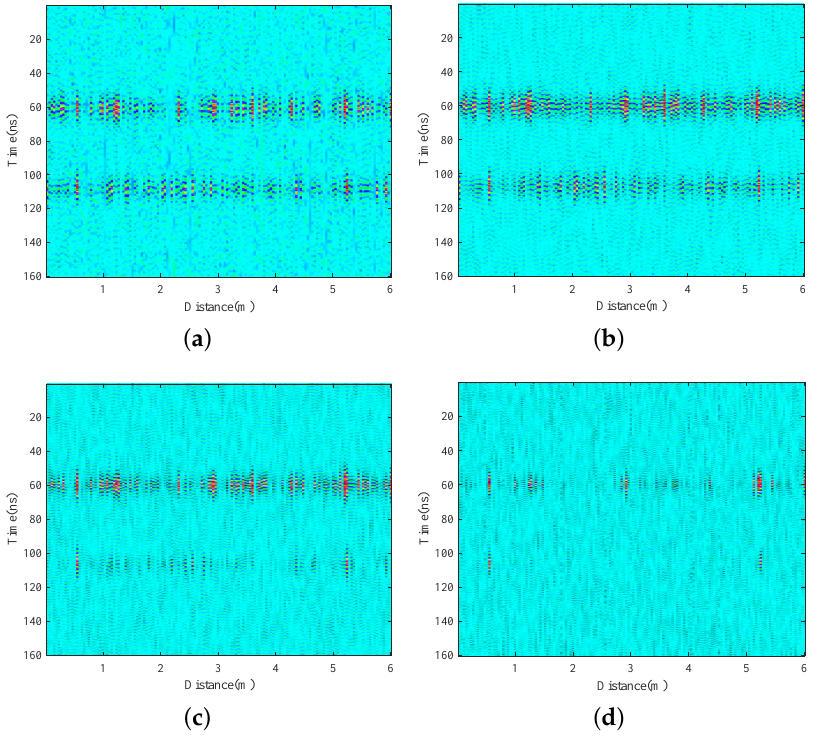
Figure 14. The IMFs obtained by WOA-VMD-BD of the simulated data in HH polarization mode.